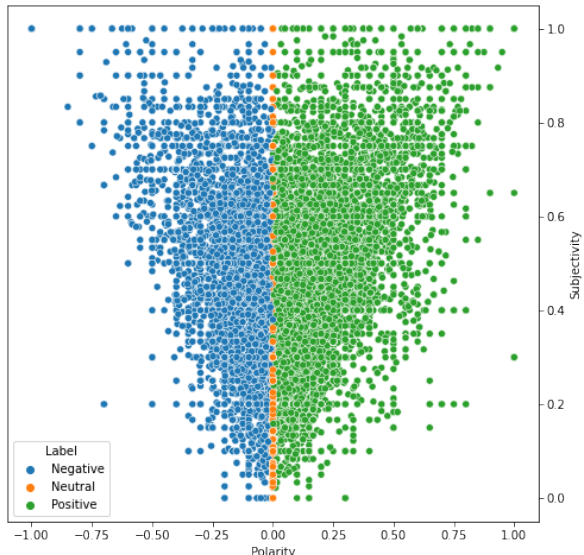
Figure 7. Subjectivity vs.